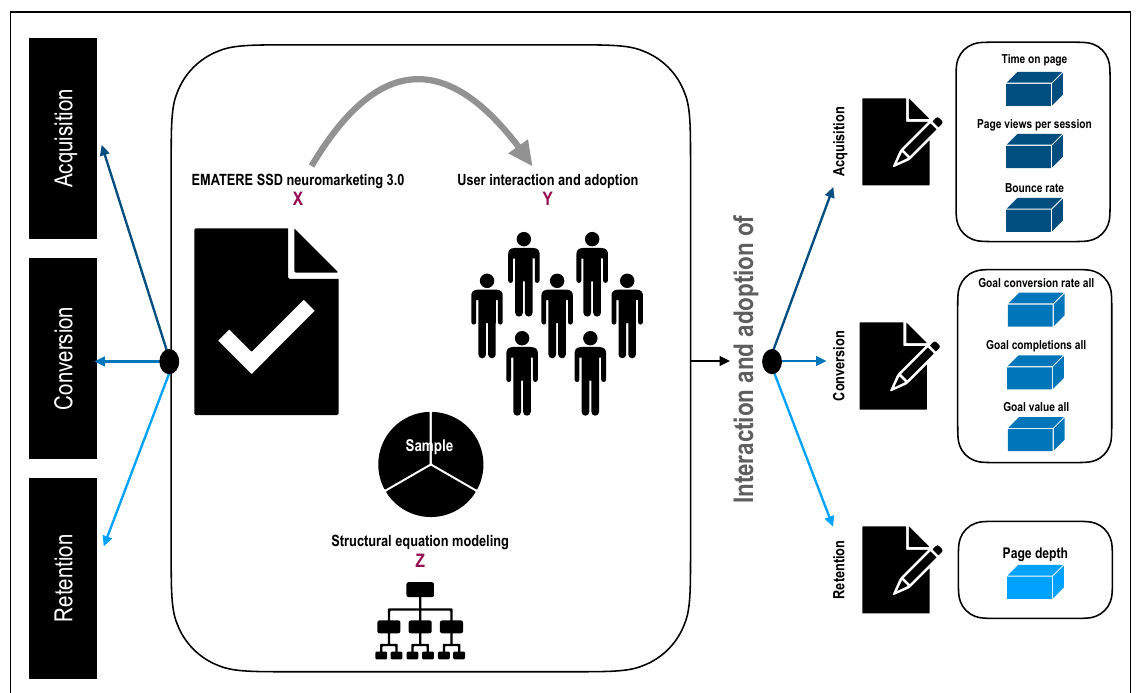
Figure 3. Methodological model of the research.